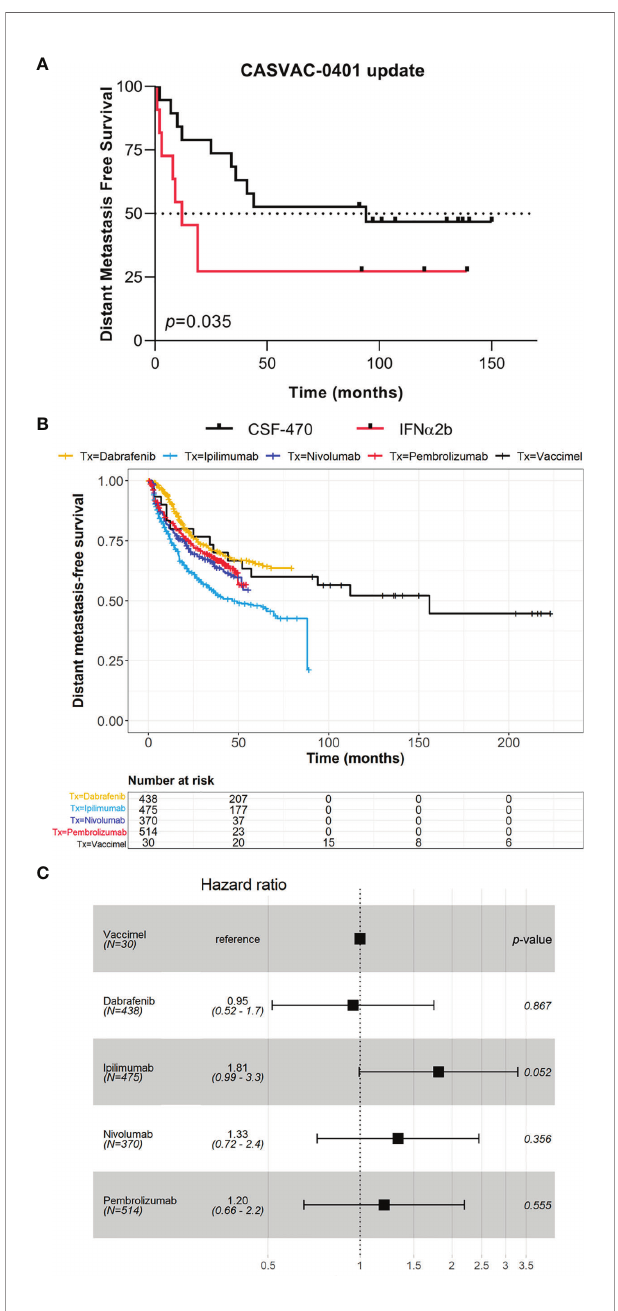
FIGURE 1 | Clinical update of VACCIMEL-immunizedpatients. (A) DMFS follow-up of the CASVAC-0401 study patients as of 10/05/2021 ( p = 0.035, Wilcoxon test).Arms: VACCIMEL (black) ( n = 19);IFN a 2b(red) ( n = 11). (B) DMFSKaplan – Meier and Cox-regression comparisonofadjuvant treatments for CM patients. Treatments: CombinedVACCIMEL-immunized patients from Phase I and II studies (black) (9, 10);dabrafenib (yellow) (28); ipilimumab(light blue) (27);nivolumab (blue) (5);pembrolizumab(red) (6). (C) Forest plot of hazard ratiocomparison of DMFSof different treatments